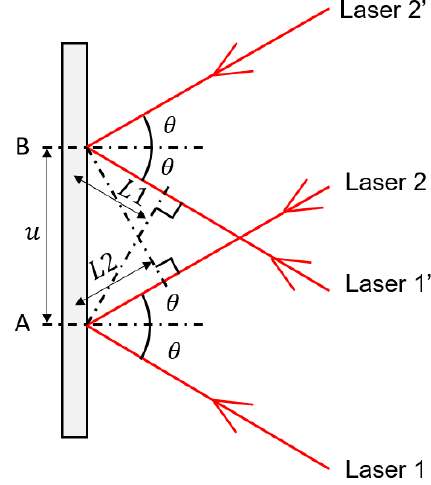
Figure A3. Speckle pattern of before deformation. ( b ) Speckle pattern of after deformation. ( c ) Fringe pattern image calculated from ( a ) and ( b ).